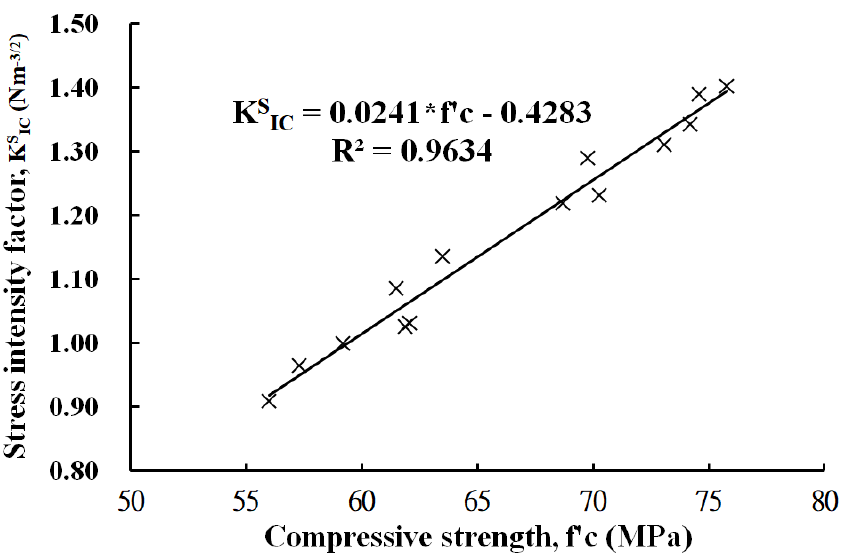
Figure 8. Stress intensity factor versus compressive strength of fly ash concrete.